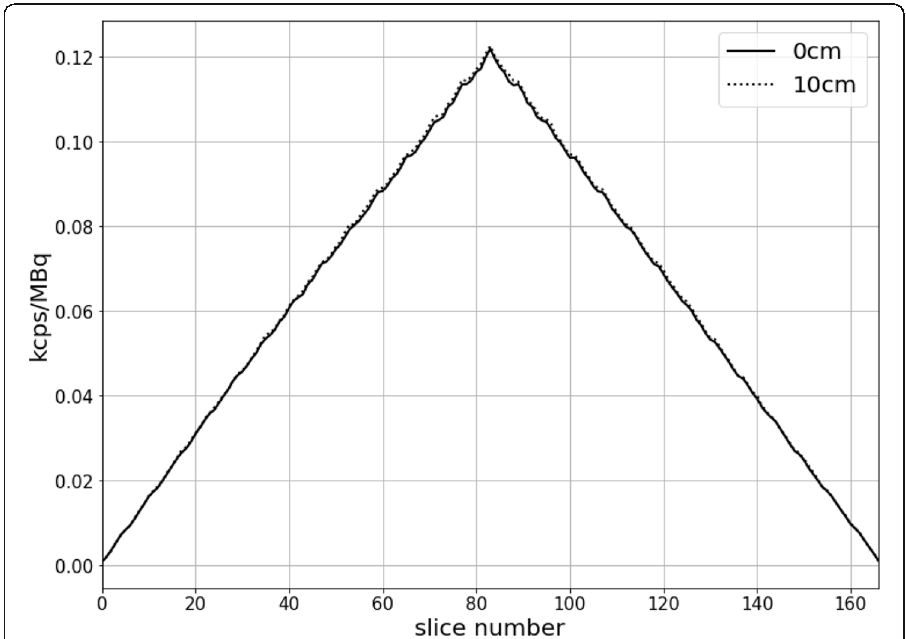
Fig. 1 The uMI550 axial sensitivity profiles for both the 0 cm and 10 cm off-center